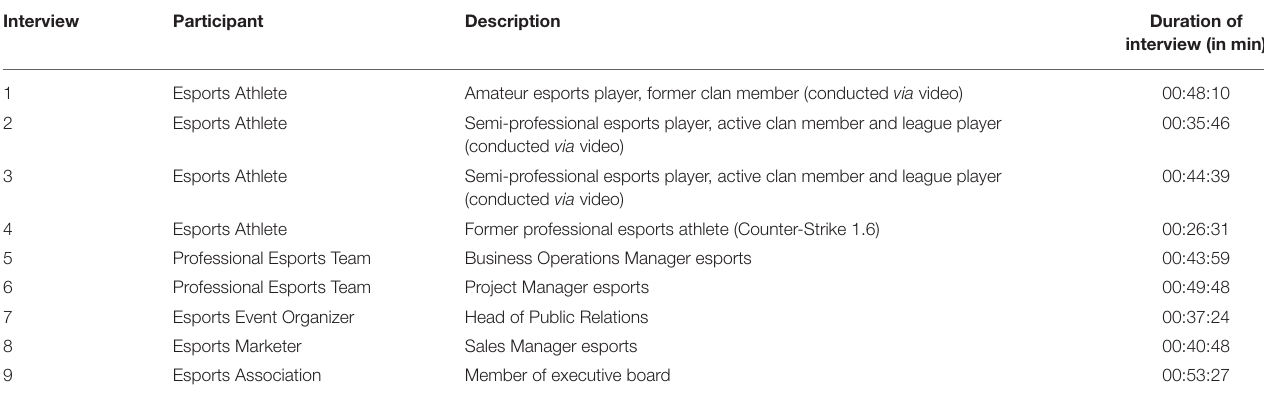
TABLE 3 | Characteristics of participants and